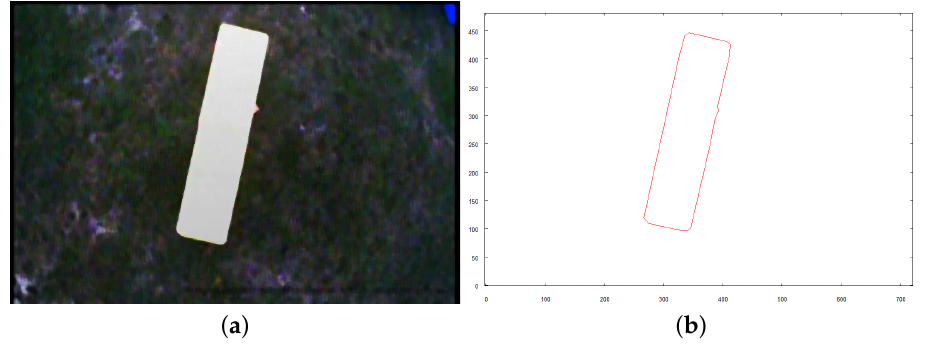
Figure 25. Intermediate steps to obtain vector representation of object C . ( a ) preprocessed image; ( b ) vector representation of